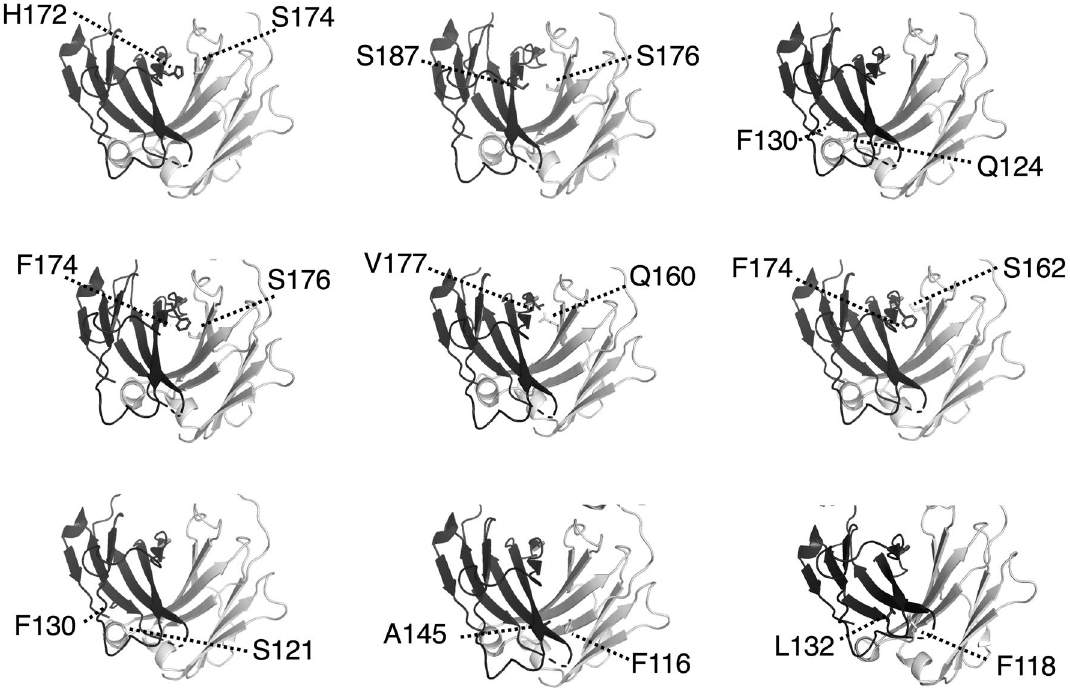
Figure 1. Mutation site of intermolecular SS mutants. Three-dimensional structure of adalimumab Fab (protein data bank number: 4NYL). The mutated amino acids are shown as